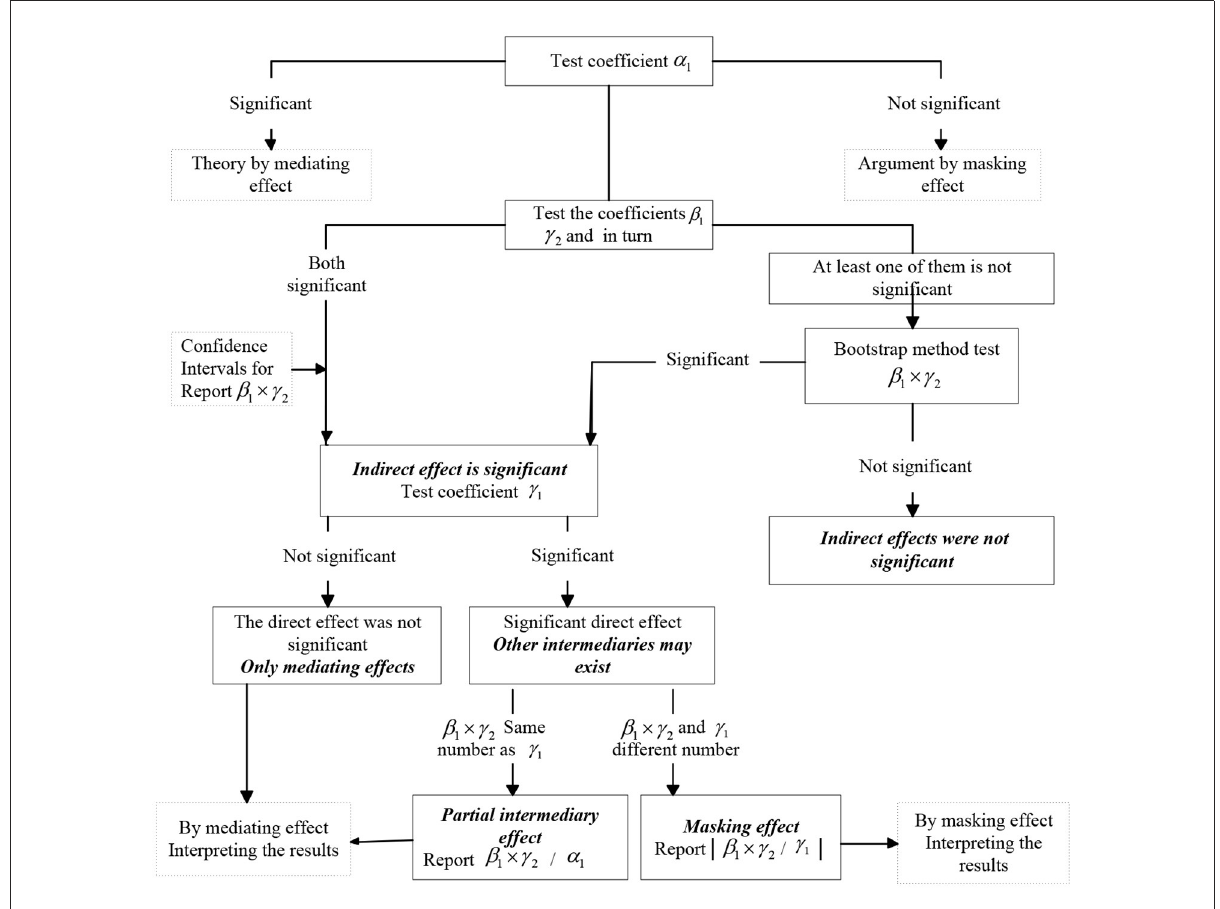
FIGURE2 Mediation effect testing